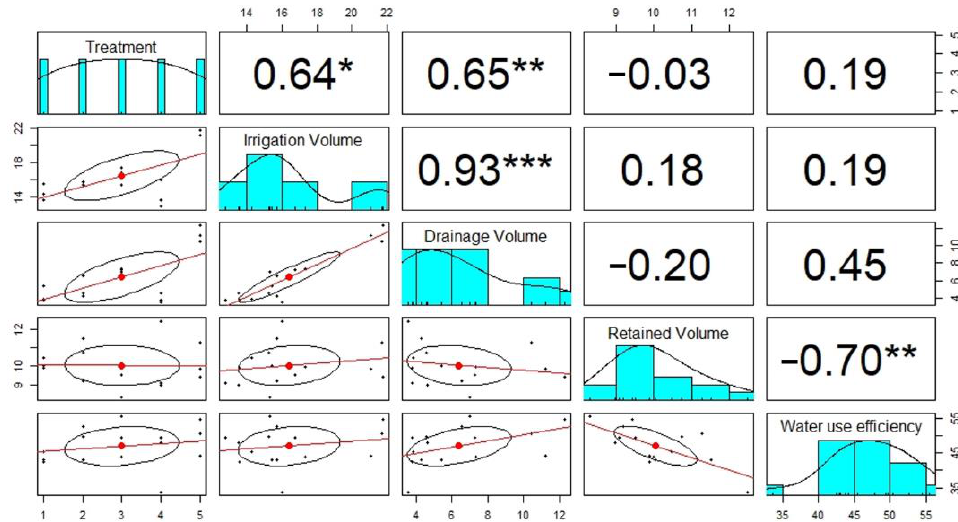
Figure 9. Water uptake characteristics correlation matrix of strawberry ‘Kuemsil’ as affected by the nutrient solution supplying system using different drainage rate levels and timings (total irrigation volume, total drainage volume, total retained volume, water use efficiency). Asterisks indicate significant differences according to Duncan’s multiple range test at p < 0.05 (*), 0.01 (**) and 0.001 (***).